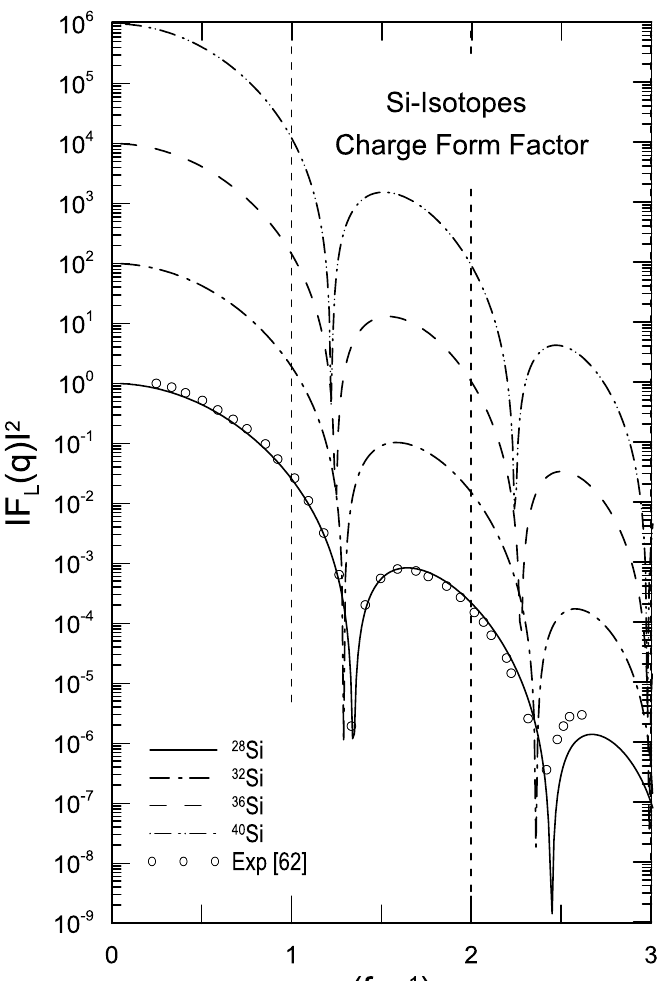
Fig.10: Longitudinal scattering form factors for 28 Si, 32 Si (× ), 36 Si (× ), 40 Si (× ). The experimental data are taken from Ref.